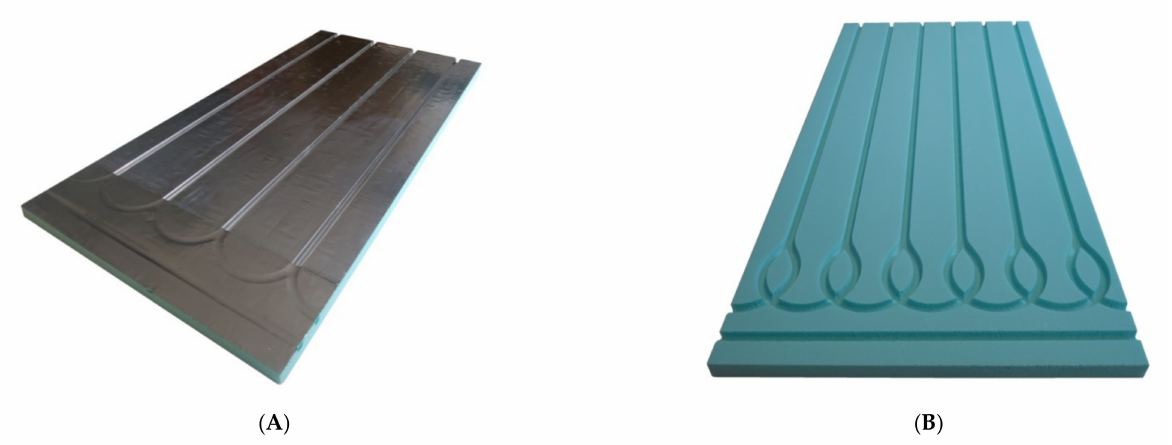
Figure 2. XPS insulation board ( A ) covered with aluminium lamella and ( B ) without